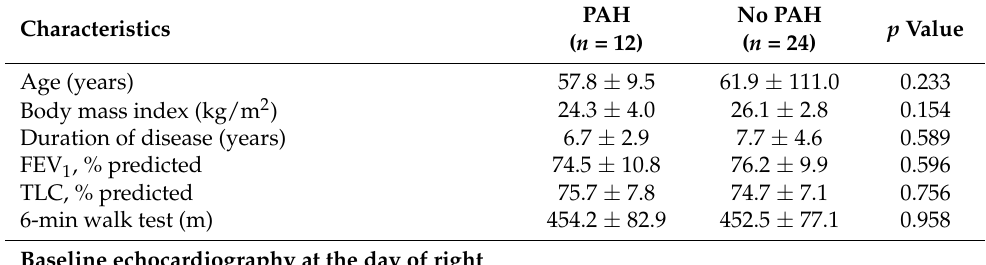
Table 2. Characteristics of the patients with systemic sclerosis according to the presence of pulmonary arterial hypertension (PAH) [mean PAP > 20 mmHg].